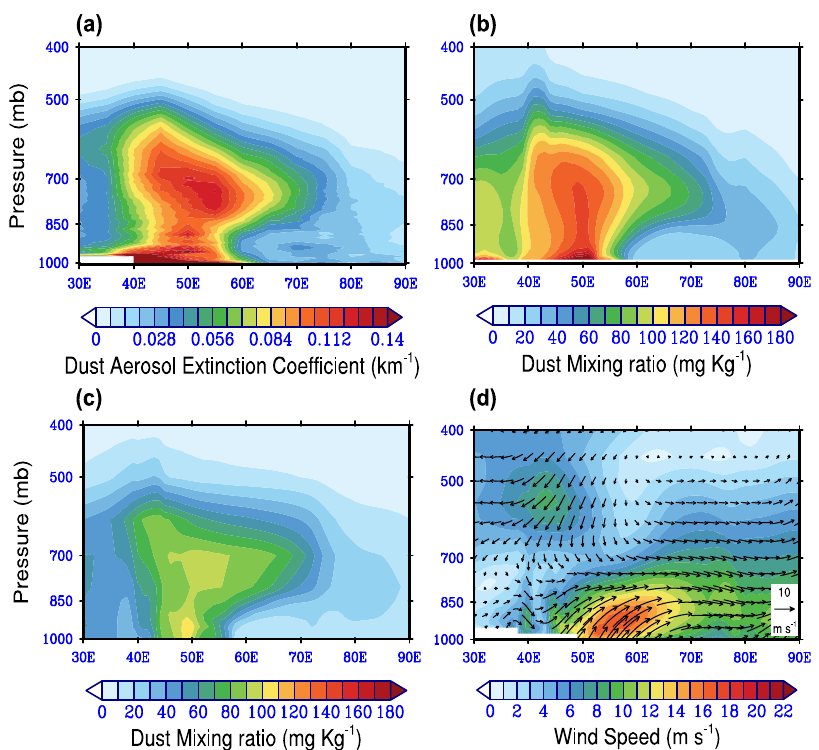
Fig. 7 Zonal dust transport over Arabian Sea during summer season. Summer climatology of the Longitude – Pressure cross-sections of a Dust aerosol extinction from CALIOP, Dust mixing ratios from b MERRA-2 and c CAMS, and d wind speed (shaded) and vectors from MERRA- 2 averaged between 5°N and 20°N during the period 2007 –